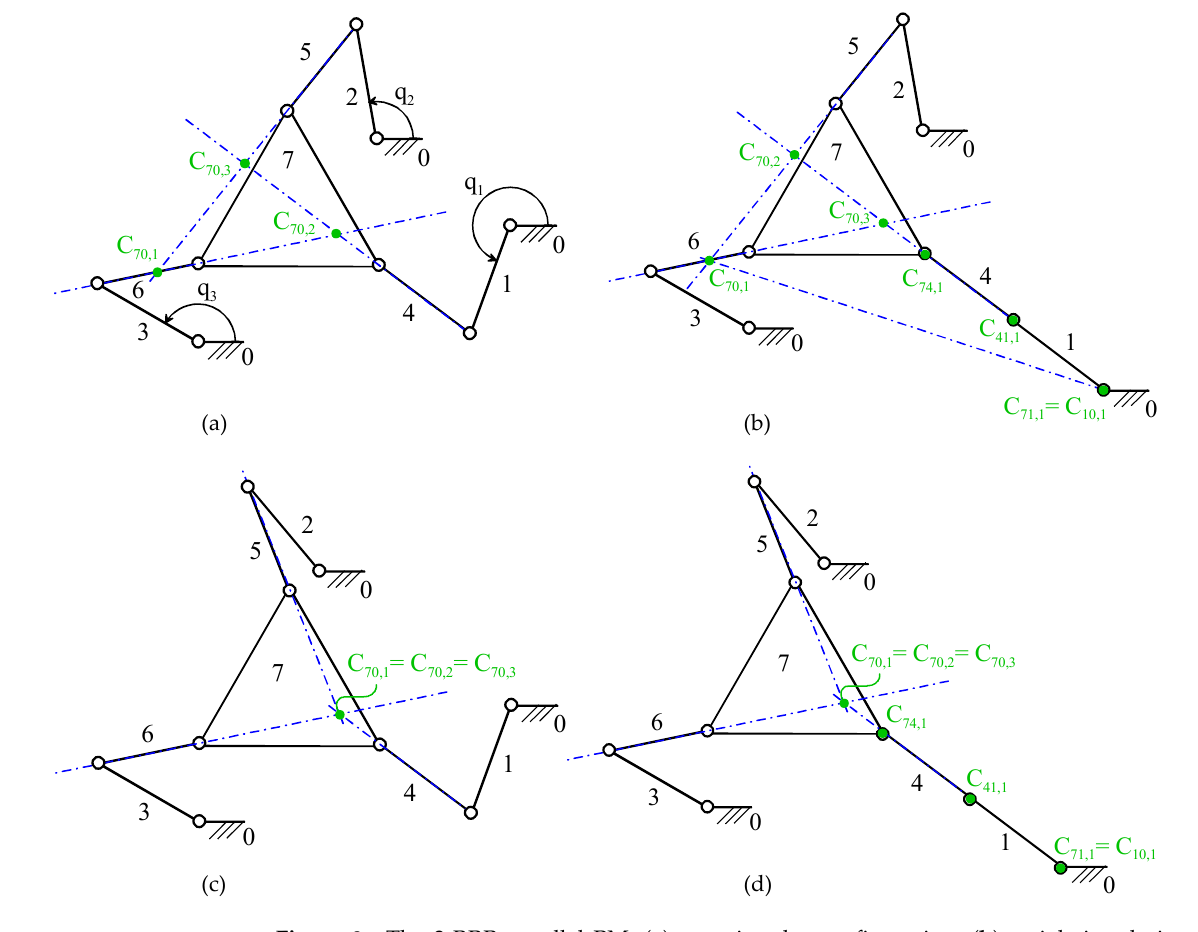
Figure 8. The 3-RRR parallel PM: ( a ) non-singular configuration, ( b ) serial singularity that is also a serial singularity of the 1st single-DOF PM (i.e., the one obtained by locking q 2 and q 3 ), ( c ) parallel singularity that satisfy Theorem 2, ( d ) type-(III) singularity that satisfies Theorem 2 and, simultaneously, is a serial singularity of the 1st single-DOF PM.